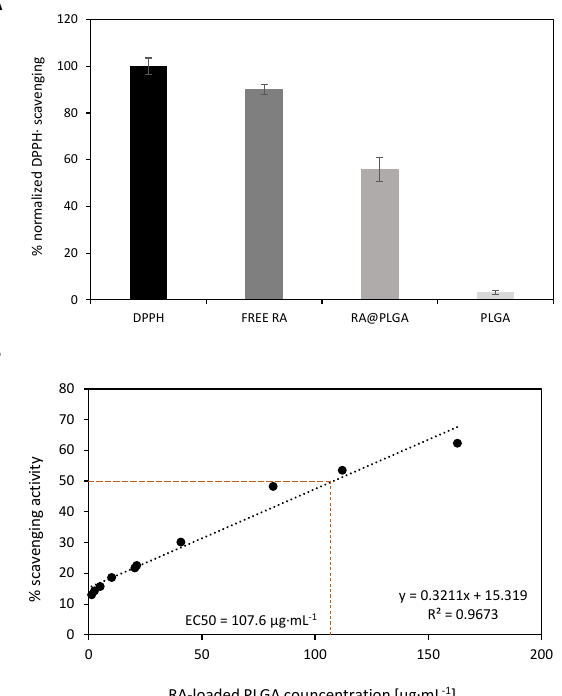
Figure 4. ( A ): Normalized antioxidant capacity of PLGA, RA-loaded PLGA, and free RA. The working concentration of bare, loaded PLGA, and free RA was 0.112 mg · mL − 1 . ( B ): Dose–response experiment involving the DPPH · scavenging activity versus RA-loaded PLGA concentration. To calculate the apparent EC 50 value, a linear regression equation (y = 0.3211x + 15.319) ( r 2 = 0.9673) was obtained. Data are averaged over three independent experiments.